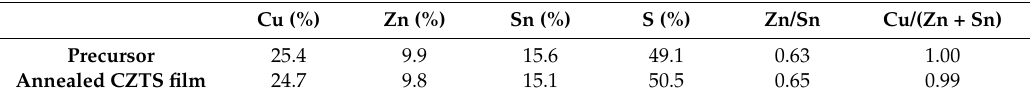
Table 1. Composition of precursor and annealed film as measured by energy-dispersive X-ray spectroscopy